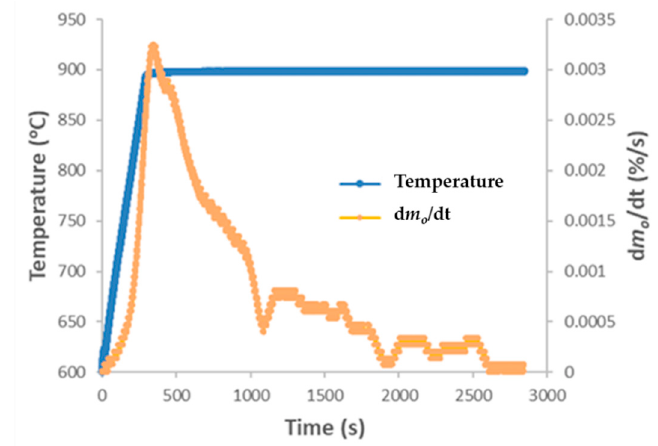
Figure 3. The Cu-OC oxygen uncoupling rate ( dm o / dt ) and reaction temperature versus time at 900 ◦ C in Ar in a TGA-QMS.